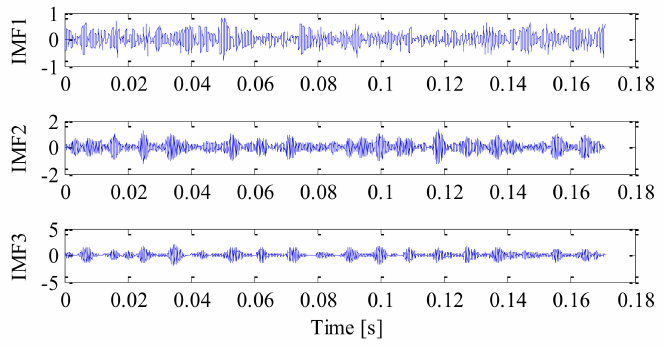
Figure 39. VMD decomposition result. Table 8. The correlation coefficient and kurtosis between IMFand original signal (VMD).